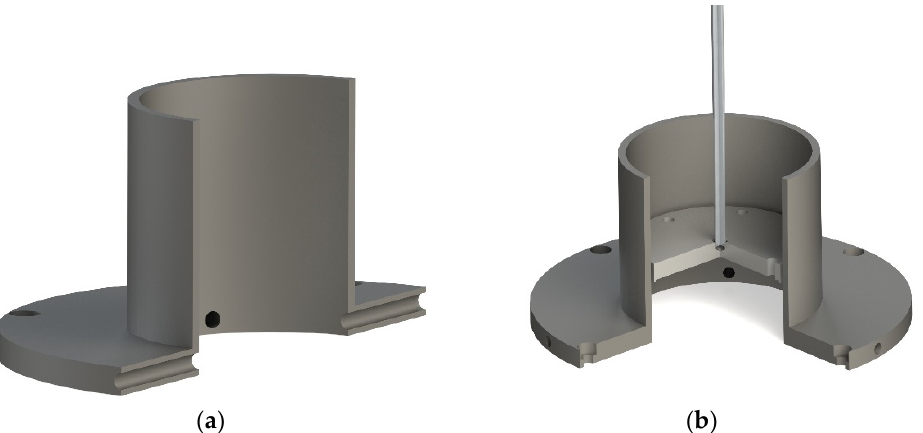
Figure 1. Design of a recovering shield ( a ); sample holder inside the recovering shield with the variable working distance range 2–5 cm ( b ).